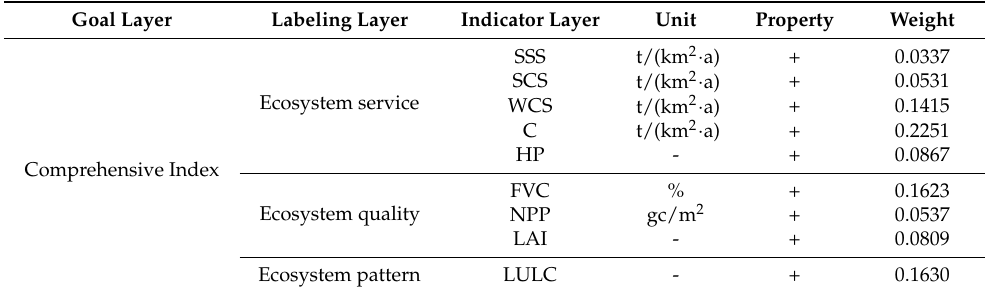
Table 1. Comprehensive index evaluation model.